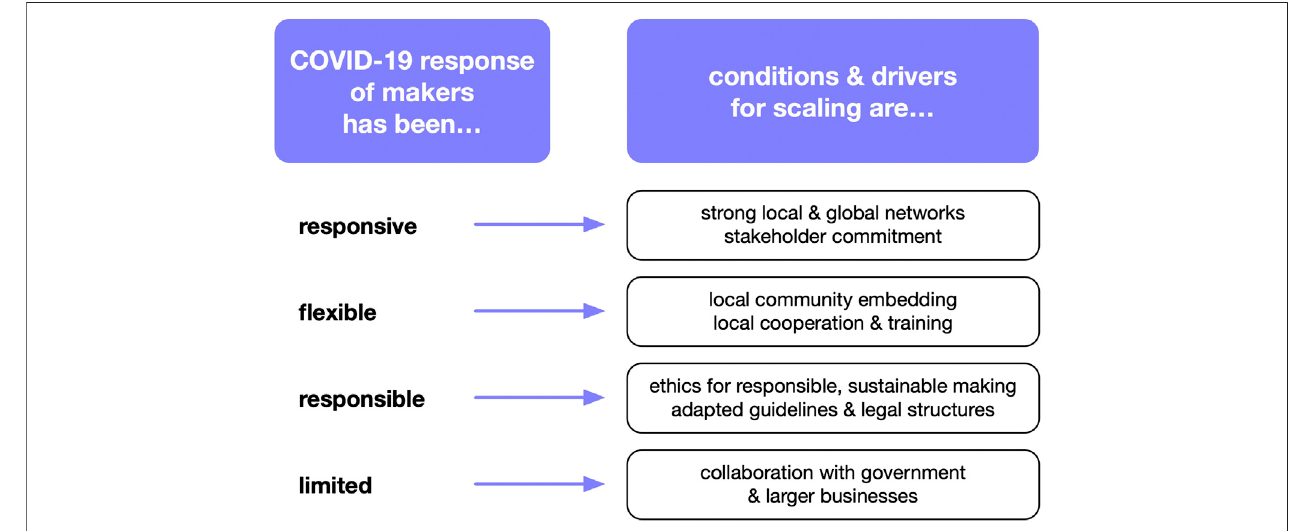
FIGURE 5 | COVID-19 maker response and